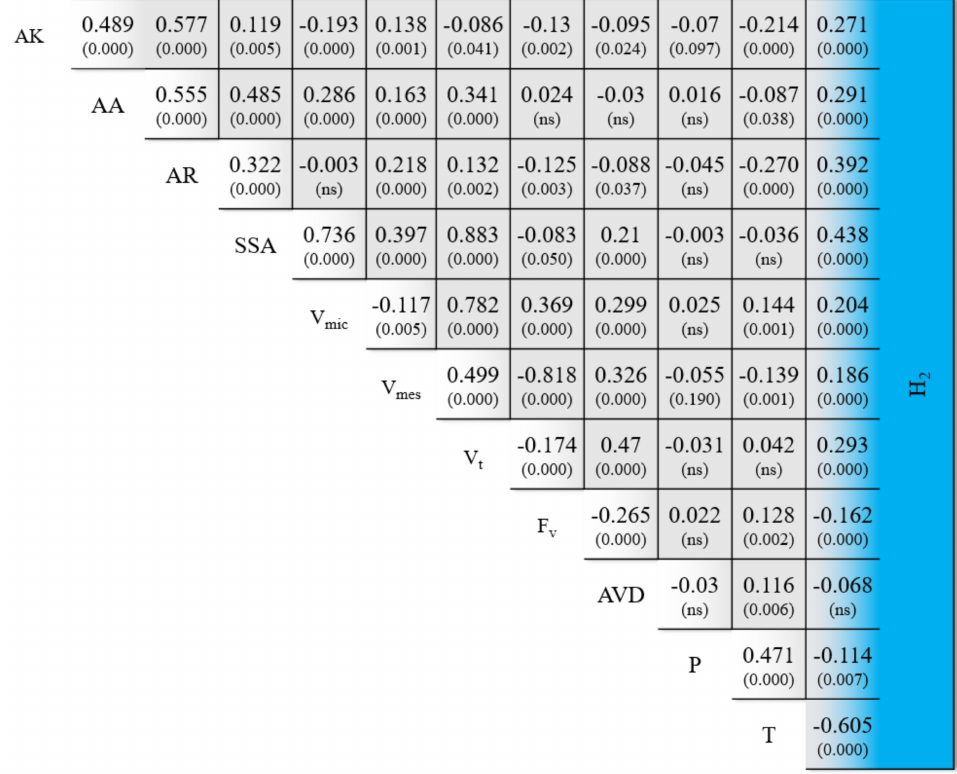
Figure 4. Pearson correlation matrix of the input variables and hydrogen uptake as an output variable. The values display the value of the correlation and the significance levels in parentheses between all